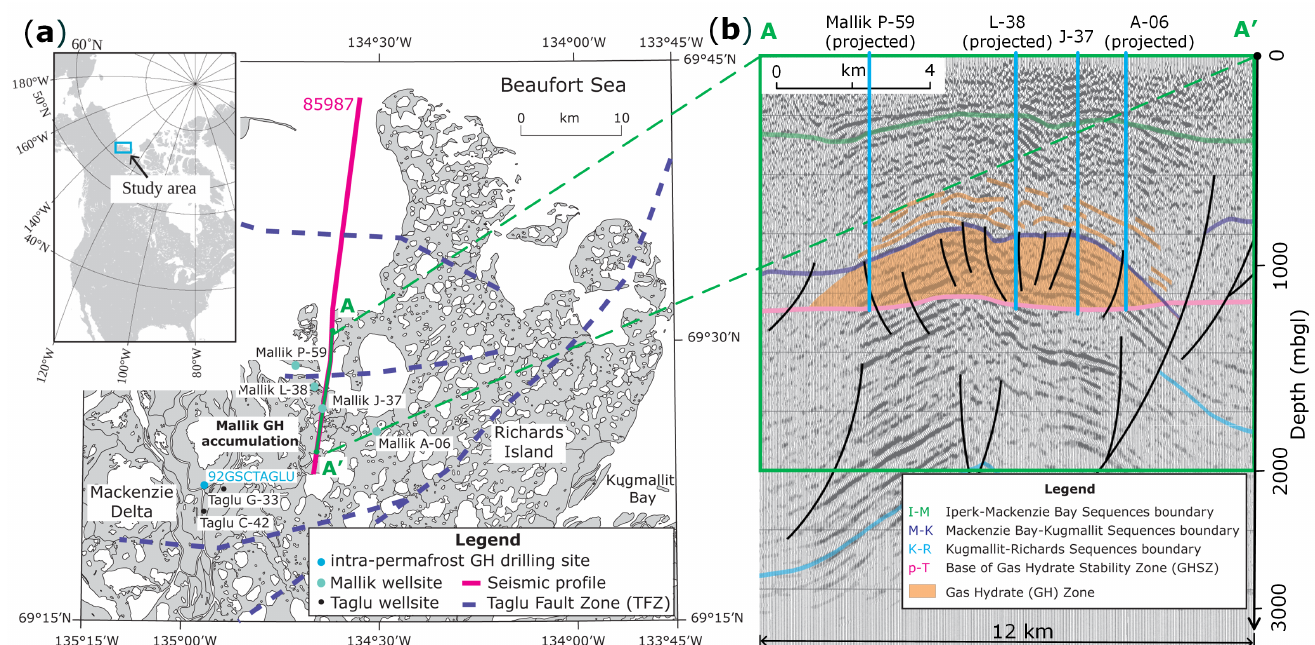
Figure 2. ( a ) Map of permafrost terrain in the Mackenzie Delta showing the seismic profile 85987, the location of the transect A-A’ and the Mallik and Taglu sites, modified from Collett et al. [45]; ( b ) inset of Mallik anticline and well locations obtained from the seismic profile, modified after [45]. The 2D seismic transect A-A’, modified on the basis of the seismic profile 85987, crossing the Mallik J-37 well location, with the industrial exploration wells Mallik P-59, J-37 and A-06 projected onto the transect. Figures presented with permission from Natural Resources Canada under the Open Government License—Canada version